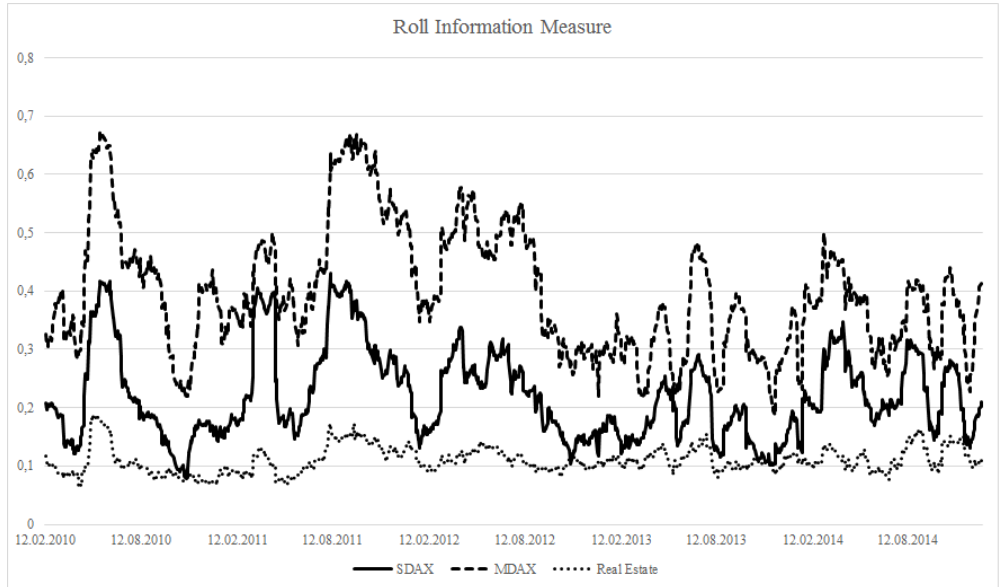
Figure 2. Estimates of rolling window roll information measures. The figure is a graphical representation of rolling window Roll information measures averaged for the sub-samples of real estate stocks, as well as the constituents of the MDAX and the